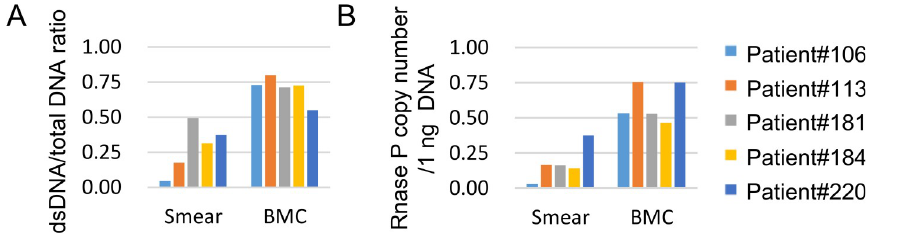
Fig 1. Quality of smear- and Bone Marrow Cell (BMC)-derived DNA samples. (A) dsDNA/total DNA ratio of the smears and BMC samples. (B) Copy number of the RNase P gene detected in smear and BMC samples.